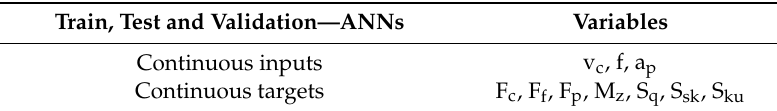
Table 5. Select variables for analysis.